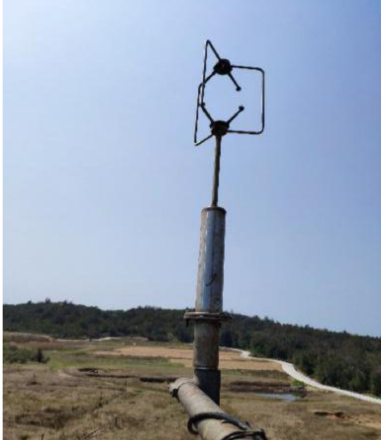
Figure 2. Sonic anemometers.